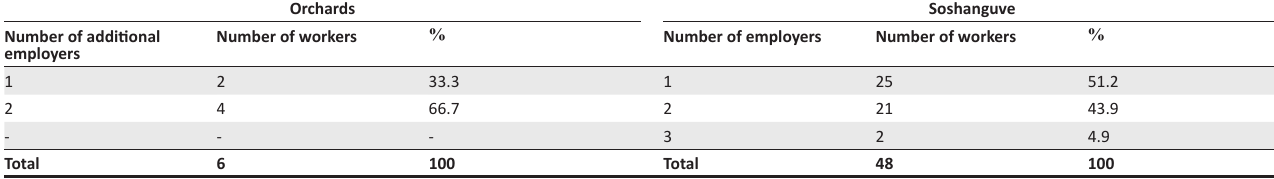
TABLE 5: Domestic workers who worked for more than one employer in 2007 – Orchards ( n = 6); Soshanguve ( n = 48). Orchards